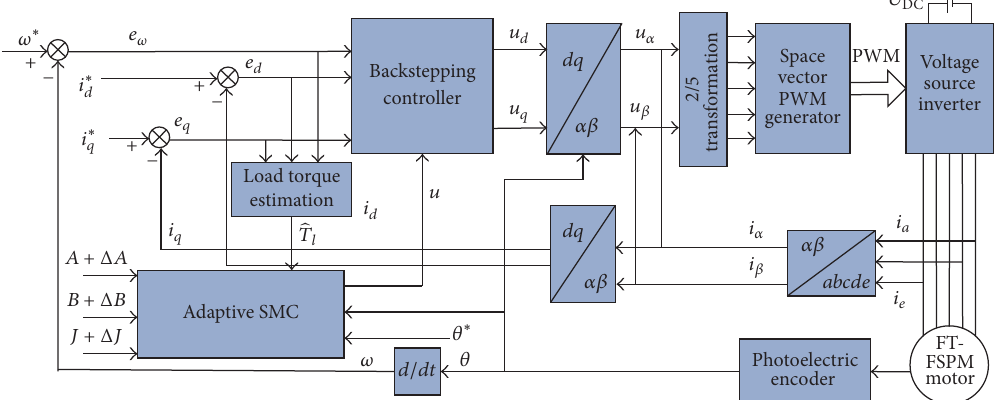
Figure 4: Block diagram of the FT-FSPM motor